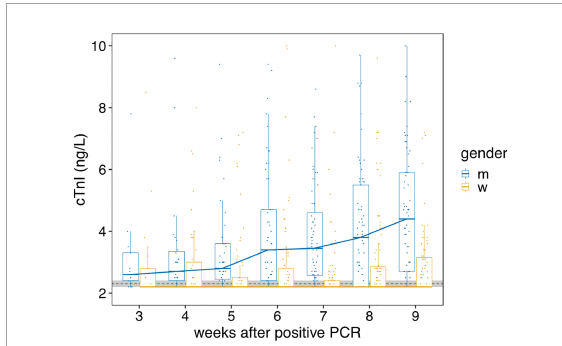
FIGURE1 Gender-dependent course of hs troponin I concentrations from week 3 to 9. The course of hs troponin I concentrations (cTnI) from week 3 to 9 [high sensitive (Beckman Coulter Switzerland, Nyon, Switzerland) assay] after mild to moderate SARS-CoV-2 infections in women (w, yellow) and men (m, blue) are displayed. The overall change of cTnI over 9 weeks is highly significant in men ( p < 0.0001), but not in women. Black dotted line indicate the limit of detection and limit of quantification, both at 2.3 ng/L. Horizontal bold lines indicate median